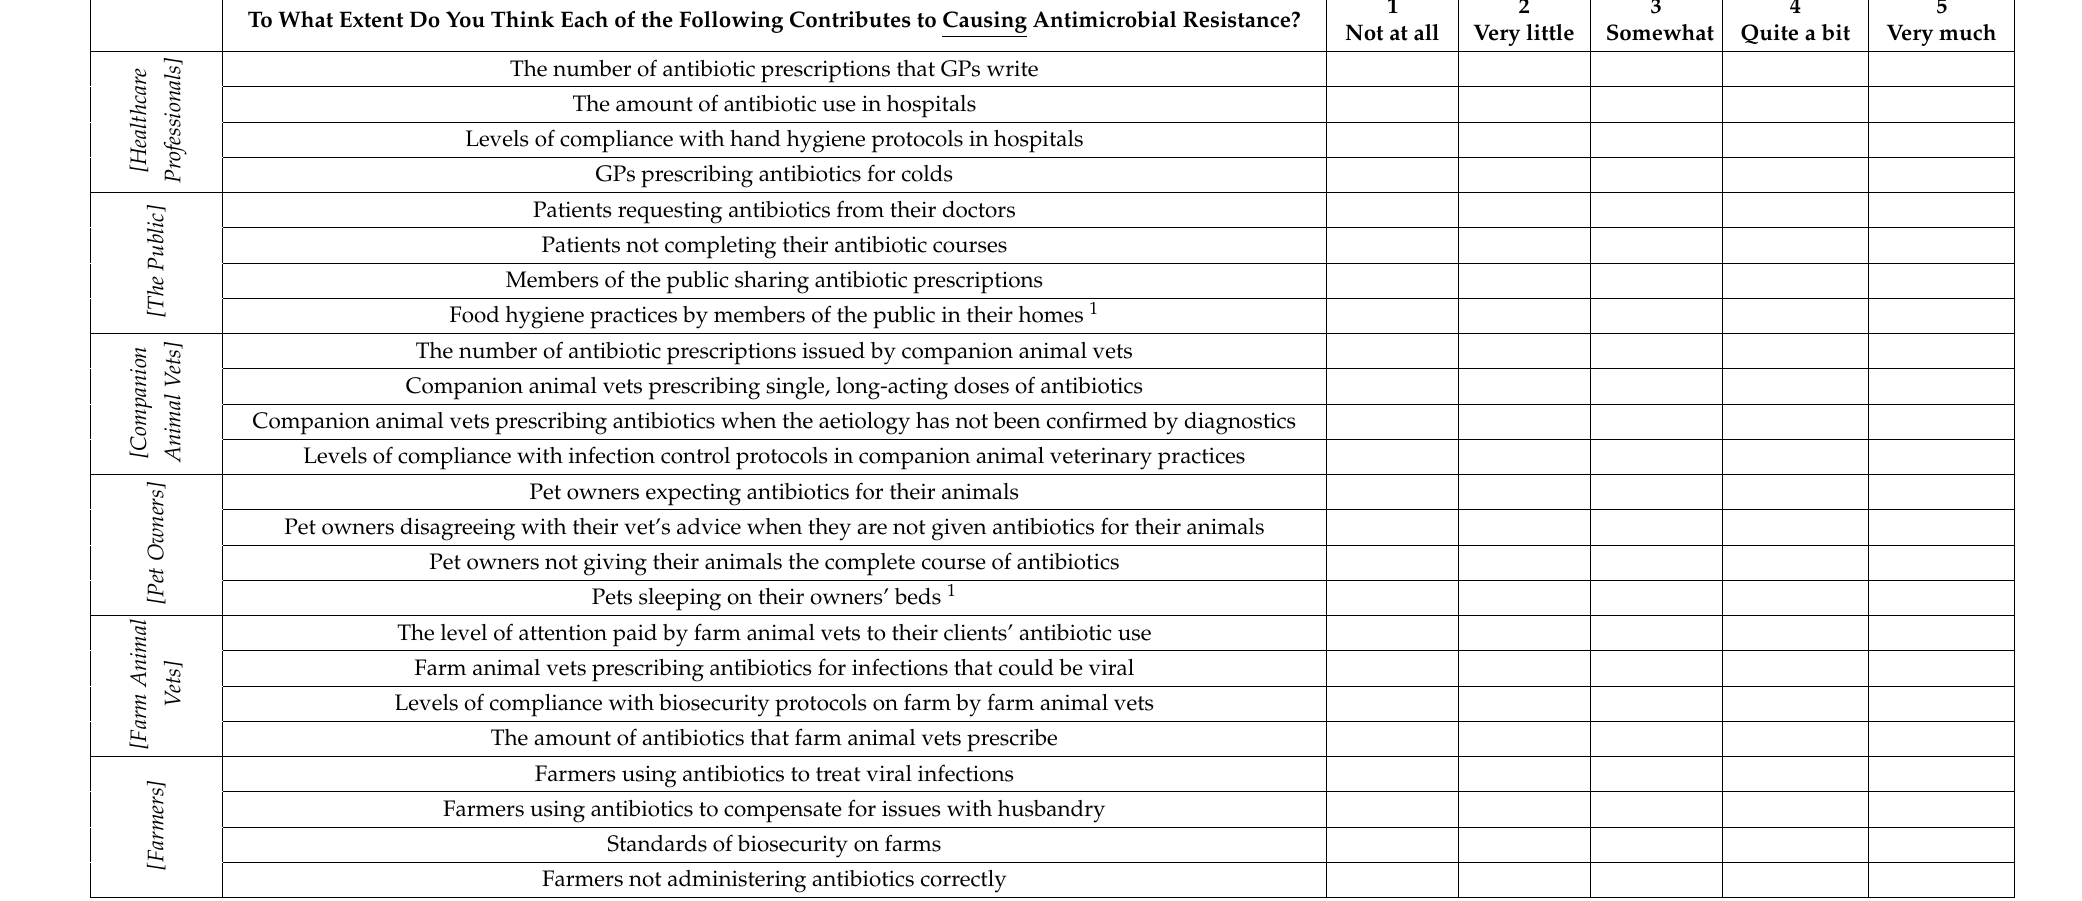
Table A1. Responsibility for causing AMR